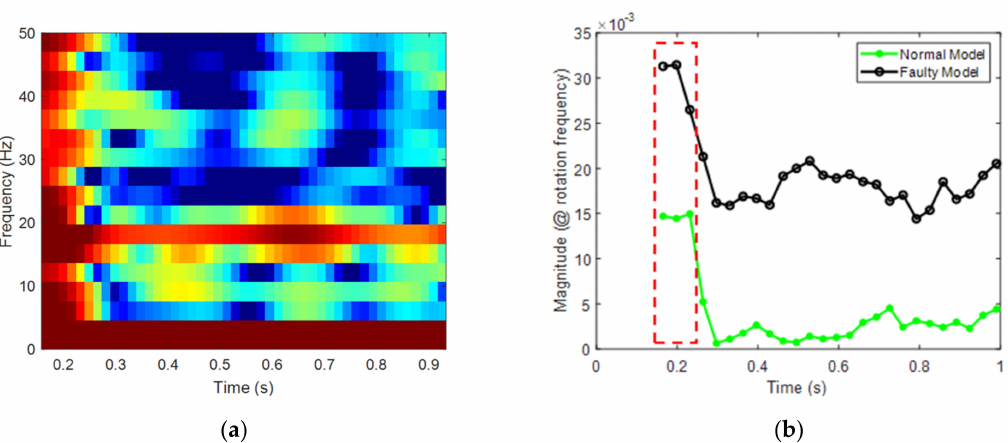
Figure 7. Case where impulsive noise is contained one time at 0.1 seconds. ( a ) STFT of envelope of faulty signal model. ( b ) Magnitude at rotational frequency of 18 Hz over time with 0.33-s-length time window and 90% overlap.